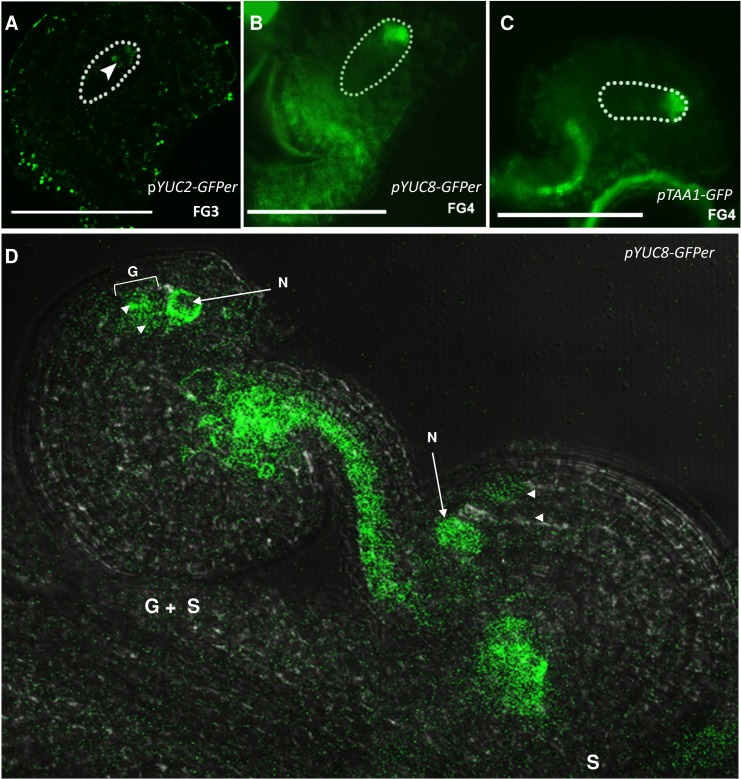
Expression pattern of auxin biosynthetic genes in the developing embryo sac.A, pYUC2-GFPer expression at FG3 stage. B, pYUC8-GFPer expression in the gametophyte at FG4 stage. C, pTAA1 expression at FG4 stage of gametophyte development. D, Segregation of GFP signal in a line hemizygous for pYUC8::GFPer. From the two ovules shown, only one presents GFP detectable inside the embryo sac (marked as G + S). S, indicates sporophytic signal; G, indicates gametophytic signal. N, nucellus. Arrowheads point at embryo sac nuclei.